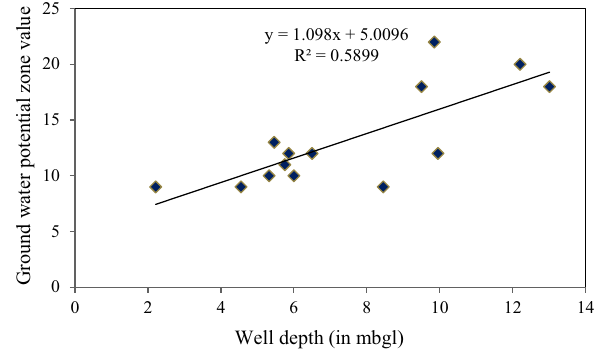
Fig. 11 Relationship between groundwater potential zone value and well depth point